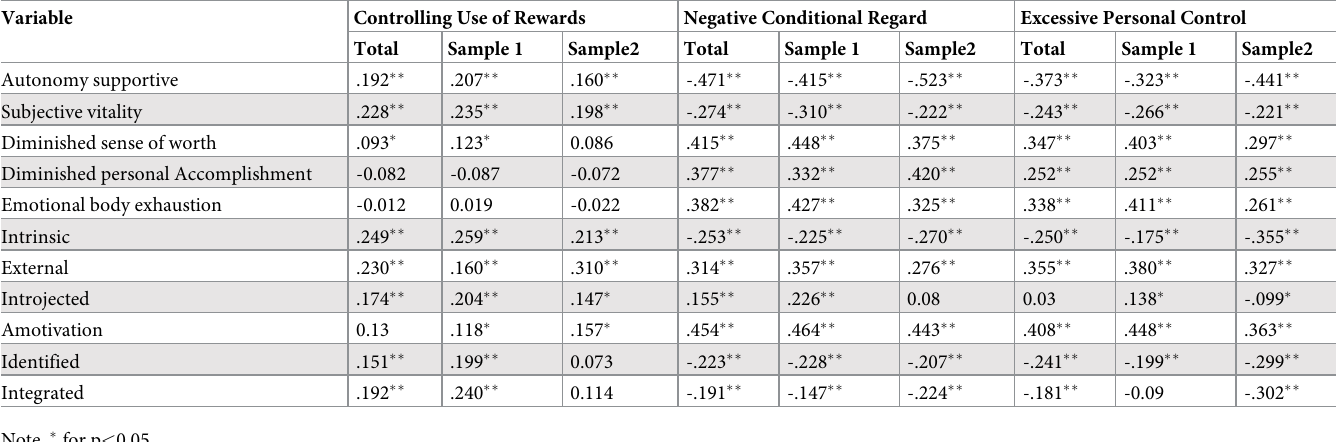
Table 2–4. The convergent vs. divergent validity of Controlling Coach Behaviors